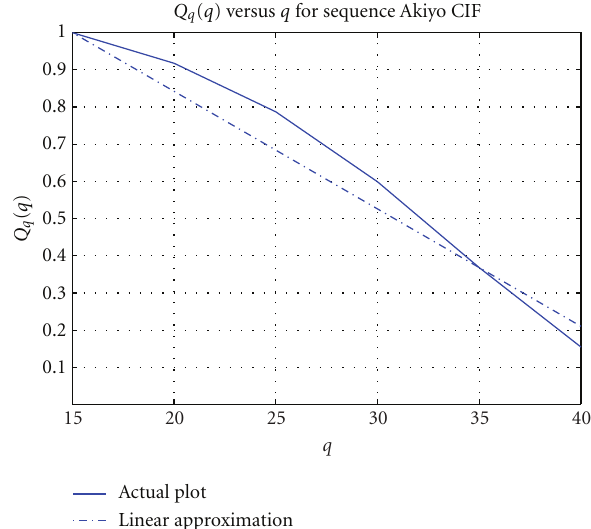
Figure 5: Video quality Q q ( q ) versus q for the video sequence Akiyo